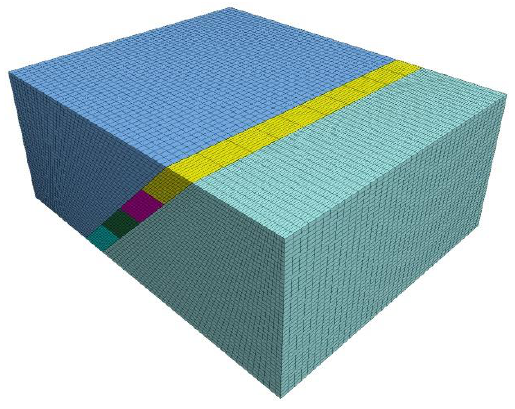
Figure 12. Numerical model.